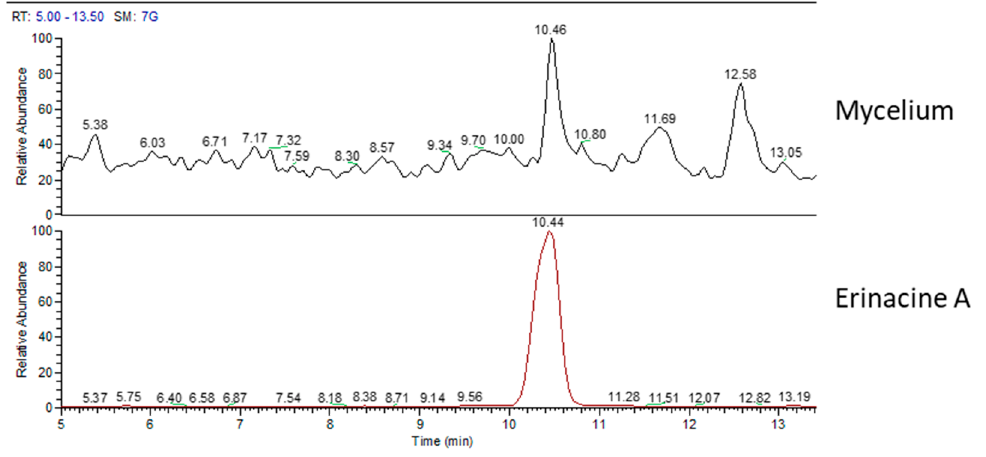
Figure 2. Mass spectrum (MS) traces of mycelium (top) and erinacine A molecule standard (bottom).